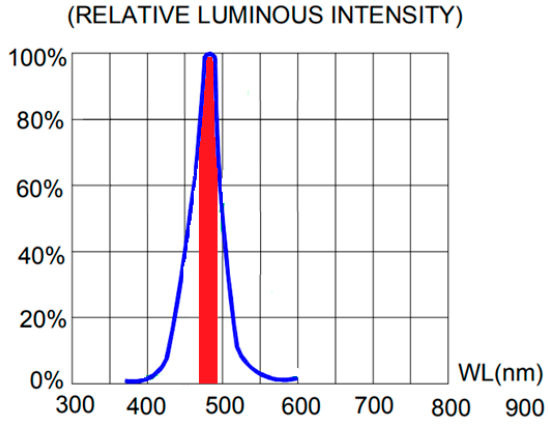
Figure 11. Representation of the useful working range of the 470 nm peak wavelength LED [36].